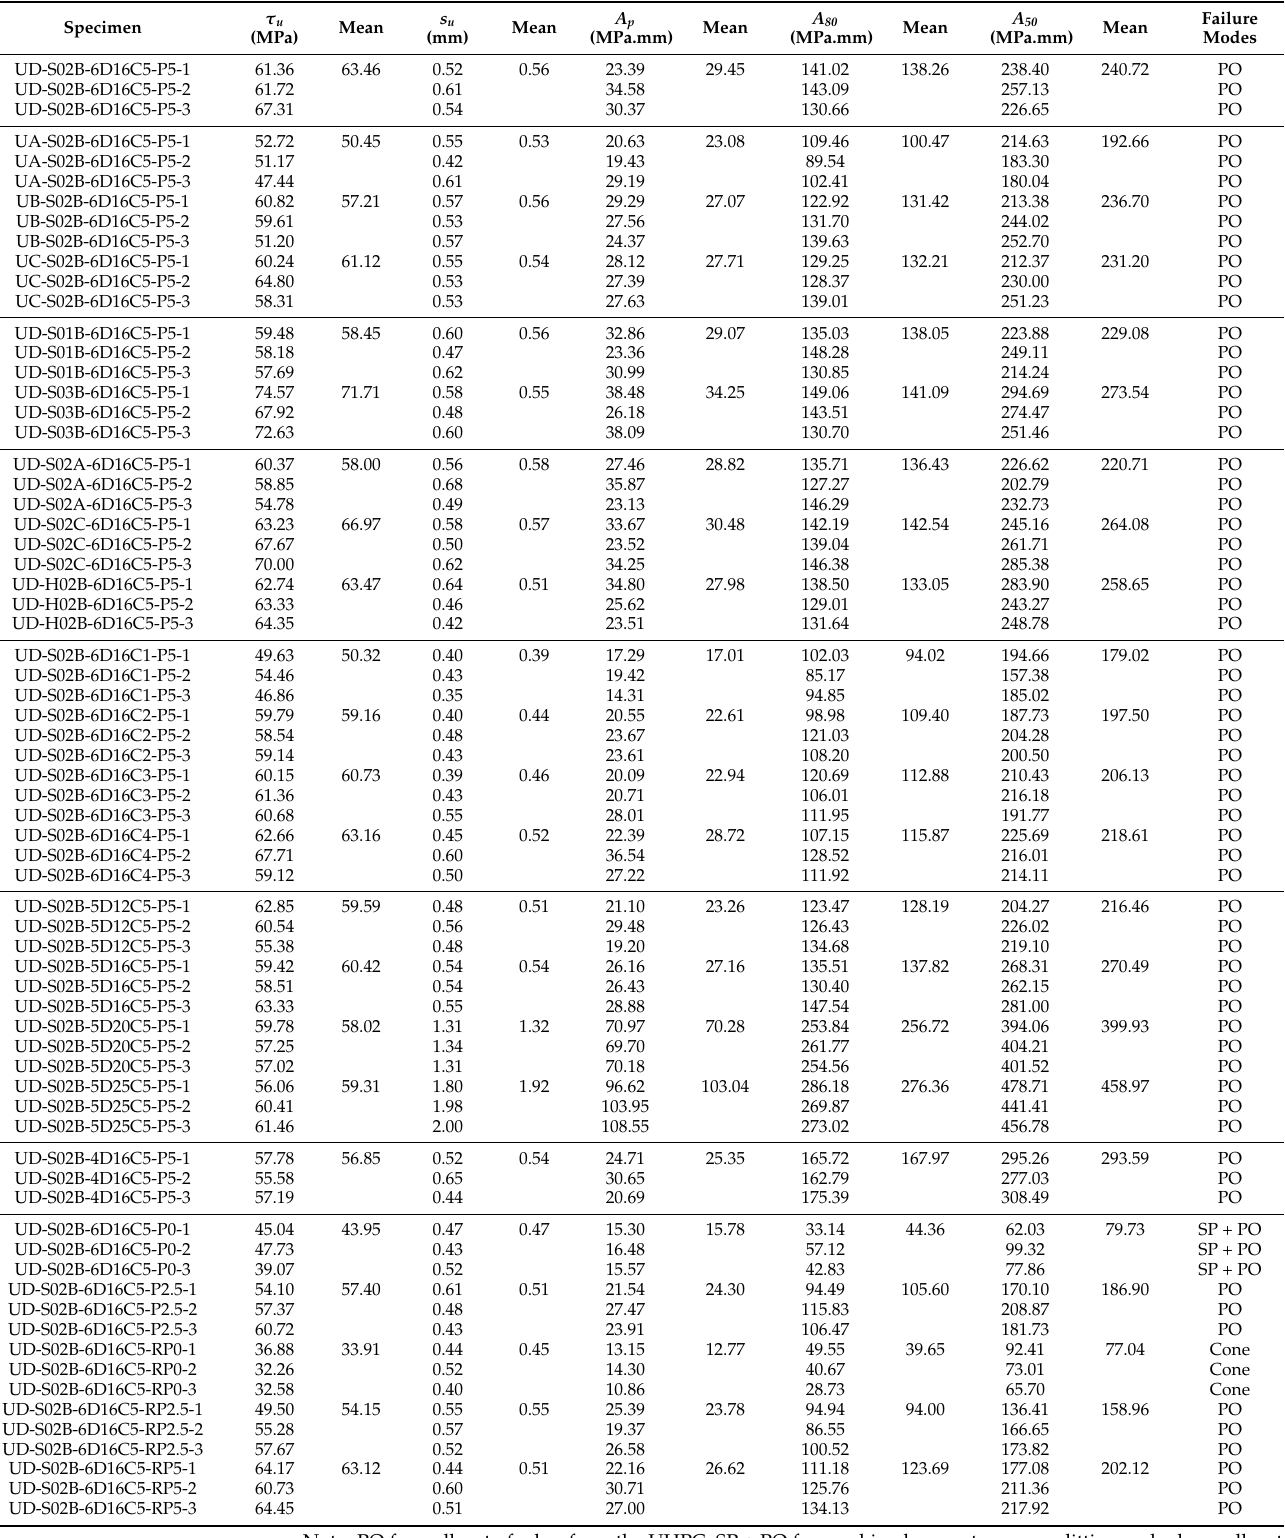
Table 6. Experimental